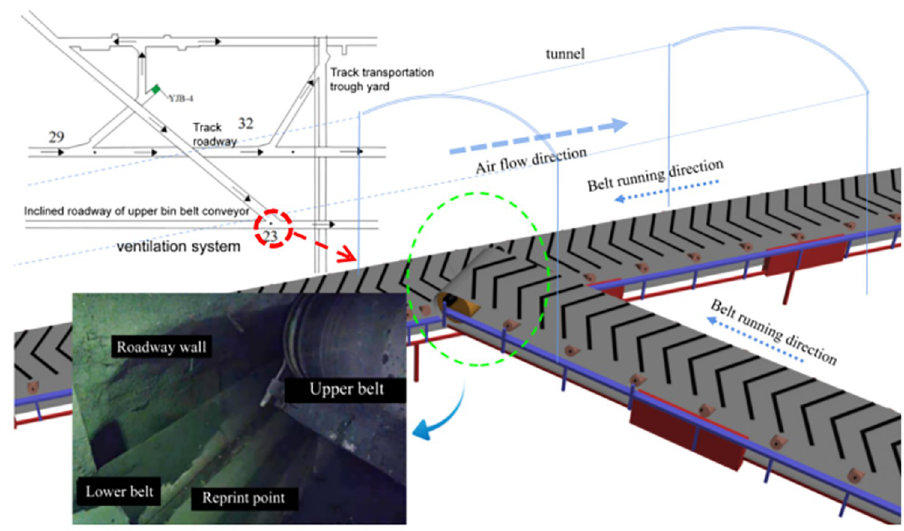
Fig 1. Physical model of the transfer point.